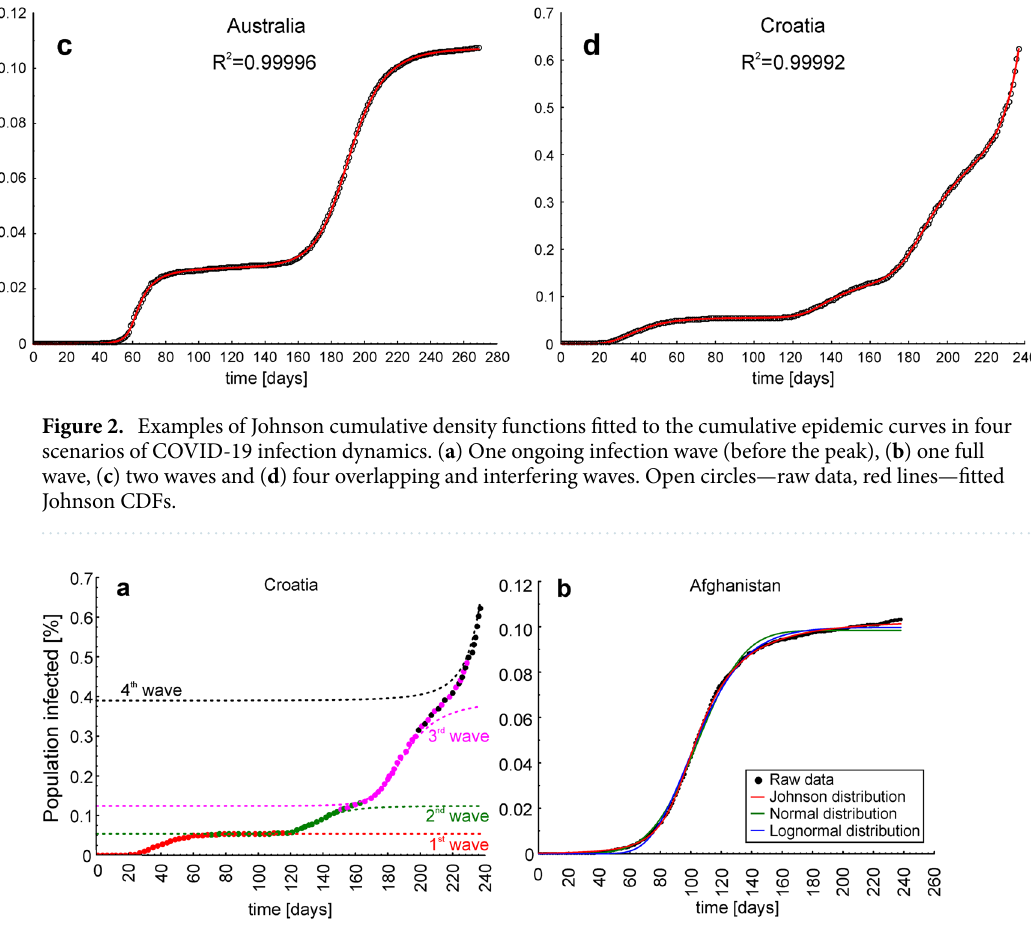
Figure 3. ( a ) Trajectory of four Johnson cumulative density functions fitted to the cumulative epidemic curve reported in Croatia, showing four waves of infections with the areas where the waves overlapped and interfered, and ( b ) the differences between Johnson (red line), normal (green line) and lognormal (blue line) cumulative density functions fitted to the cumulative epidemic curve from Afghanistan (black